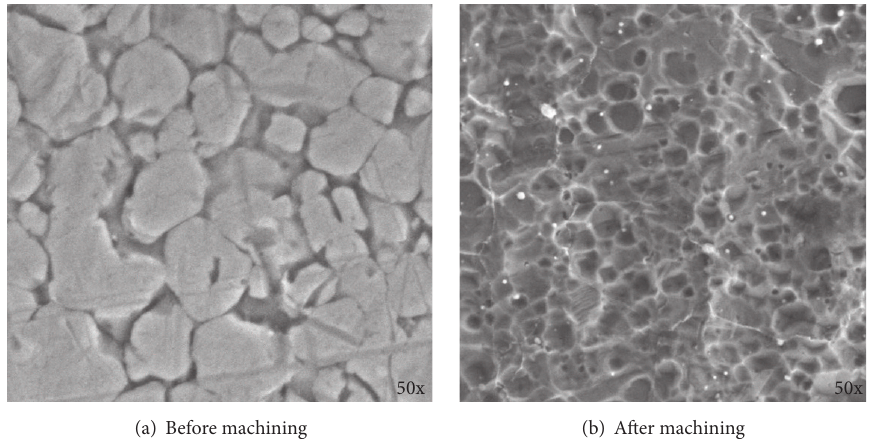
Figure 9: SEM images showing the surface morphology of Inconel